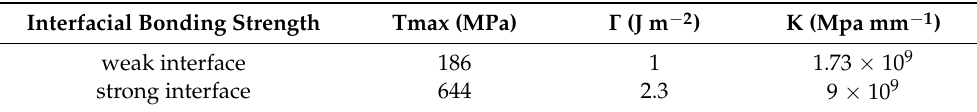
Table 1. The cohesive parameters of the microstructure model of alumina/graphene composite ceramics (AG) [32].